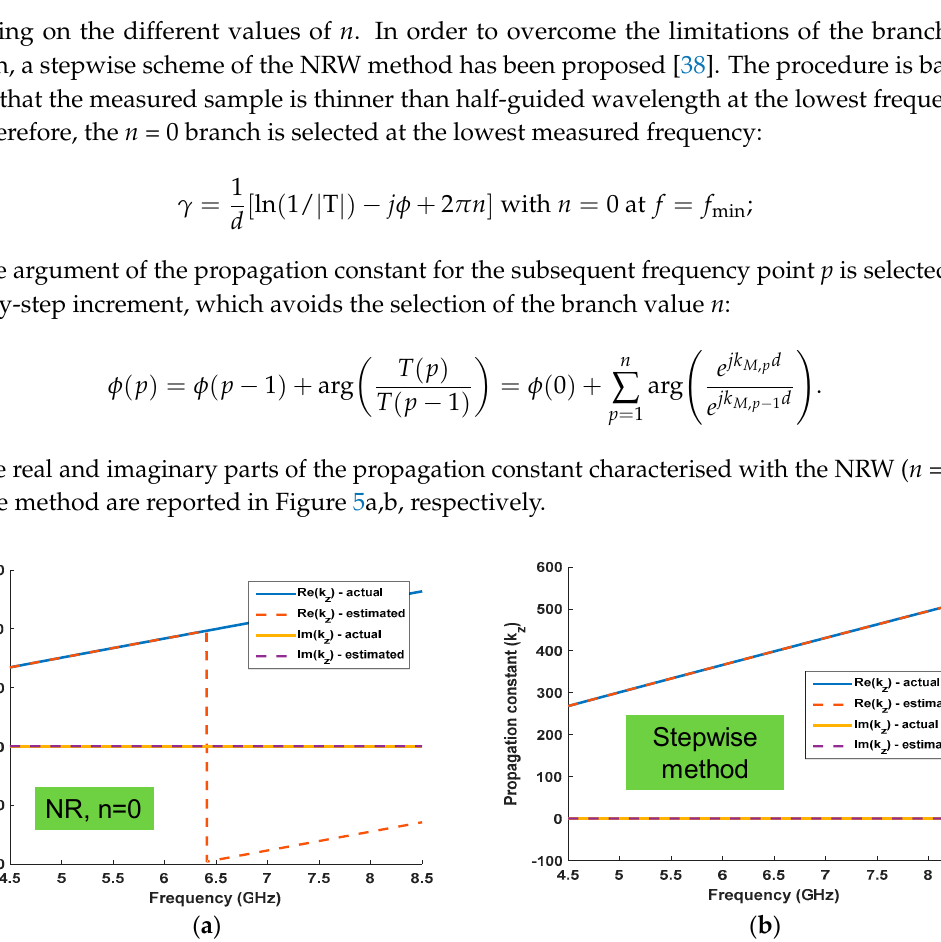
Figure 6. ( a ) Scattering parameters for a sample of ε r = 30 − j0.2, µ r = 1 − j0 with d = 8 mm; ( b ) estimated dielectric permittivity for n = 0 and n = 1.